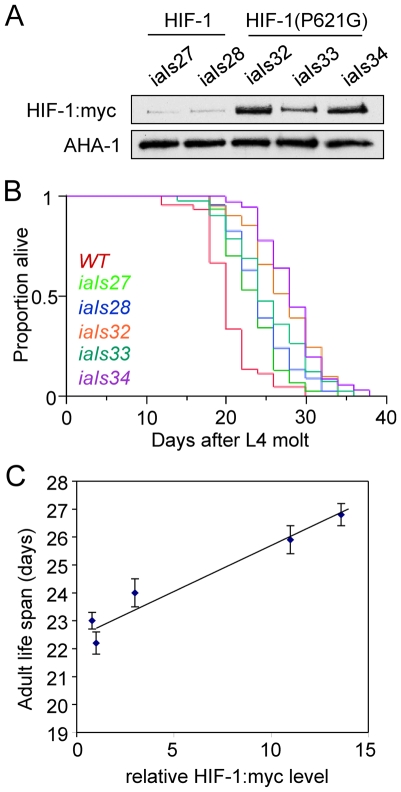
HIF-1 over-expression extends longevity in a dose-dependent manner.(A) Protein blots quantitate expression of HIF-1 and HIF-1(P621G) transgenes (tagged with the myc epitope). iaIs27 and iaIs28 contain integrated copies of the hif-1 minigene. iaIs32, iaIs33, and iaIs34 carry integrated copies of hif-1 (P621G). (B) Strains carrying hif-1 transgenes live longer (p<0.0001). Proportion alive is plotted over time. (C) The mean adult lifespans of strains over-expressing HIF-1 are positively correlated with the HIF-1 expression levels. Error bars represent the standard errors of the means.